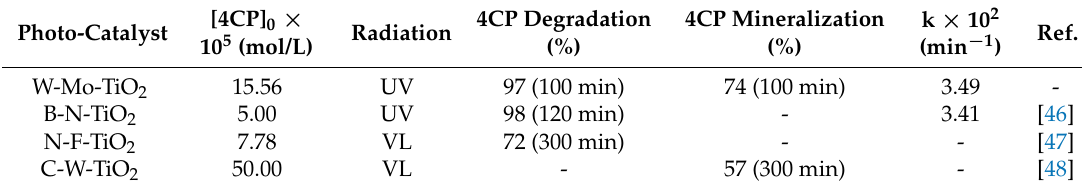
Table 5. Photocatalytic performance of W-Mo-co-doped TiO 2 compared to other reported co-doped TiO2 materials.